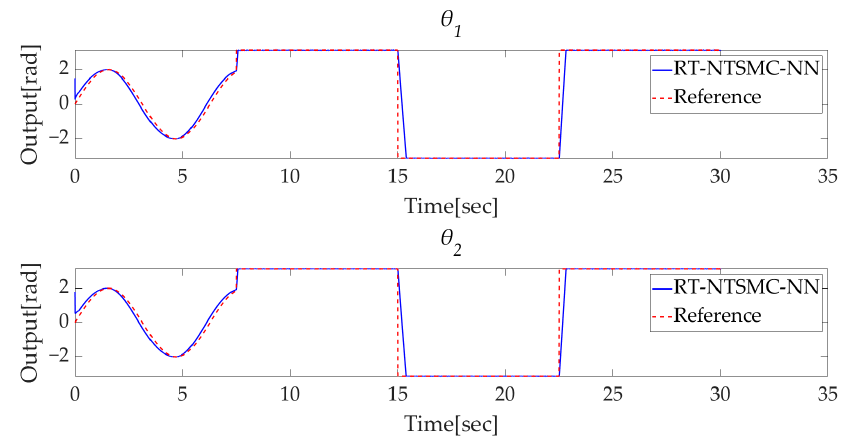
Figure 17. NTSMC-NN controller performance for mixed input.